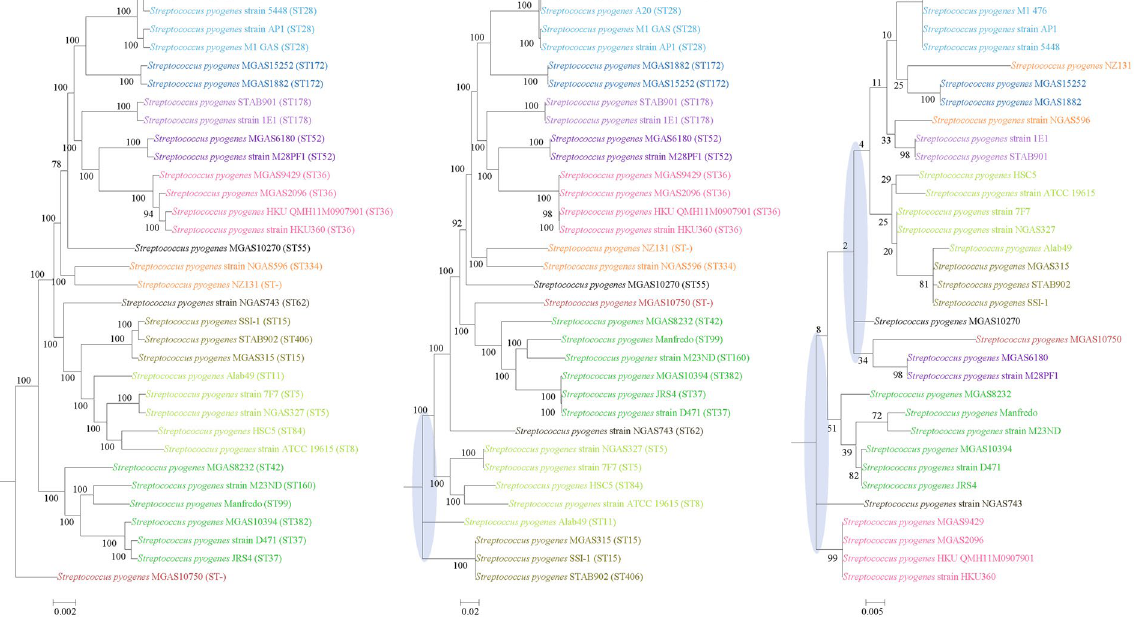
Figure 9. Comparison of phylogenetic trees constructed using genome data (left), SNP data (middle), and MLST data (right) for Streptococcus pyogenes . Clusters that were manually selected based on the genome trees are illustrated in different colors. The unresolved polytomies are shaded in blue. A new sequence type is represented by a dash